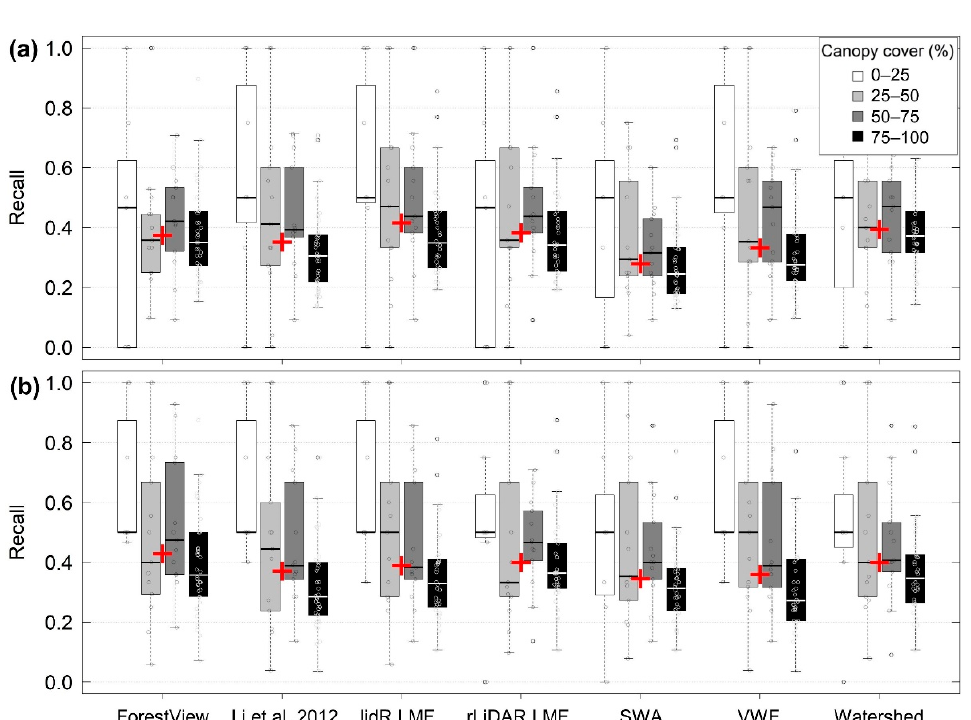
Figure 4. Recall results of the top ITD method approaches highlighted in Table 4 and derived from the ( a ) 8 ppm 2 ALS dataset and ( b ) 22 ppm 2 ALS dataset and stratified by ALS-derived canopy cover. Red crosses represent median recall values across all plots.